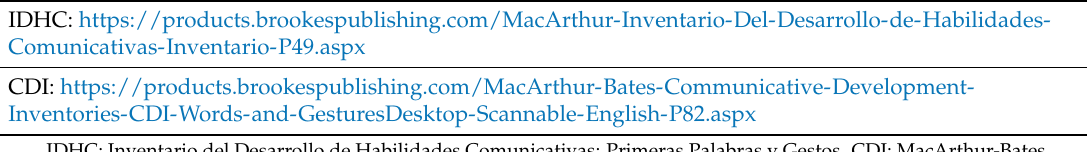
Table A1. Links to parent language checklist measures.